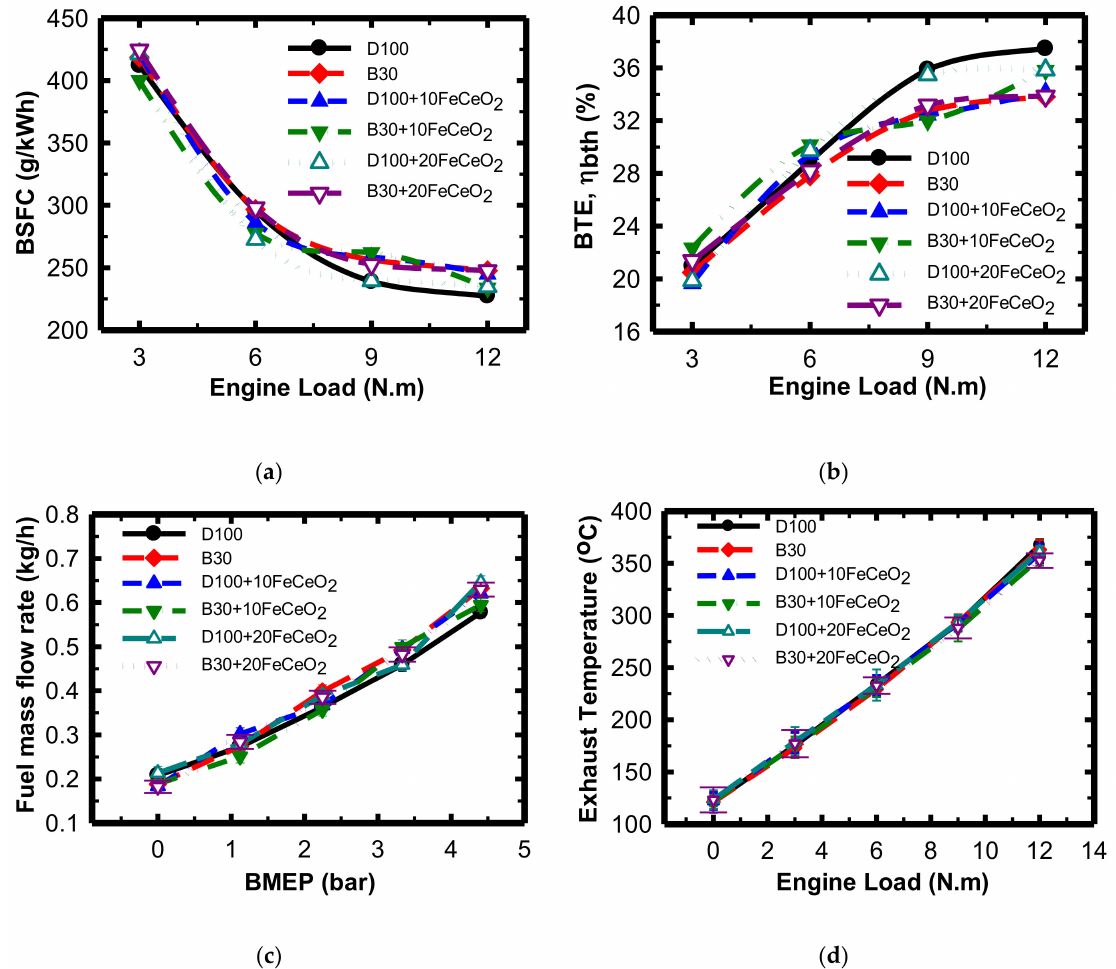
Figure 8. The variation of engine performance parameters with load at a speed of 2000 rpm: ( a ) BSFC; . m fuel ); and ( d ) exhaust gas temperature, T Exh ( b ) BTE ( η bth ); ( c ) fuel mass flow rate (